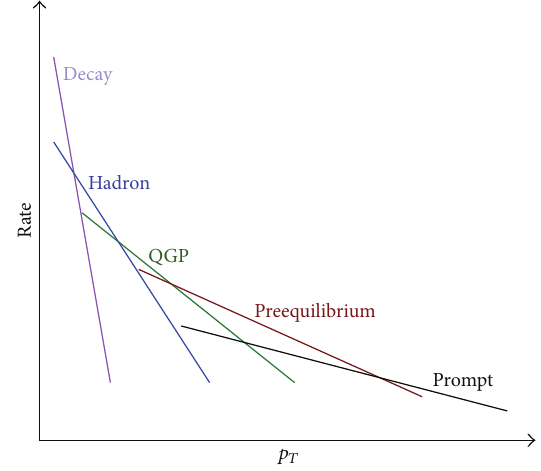
Figure 1: Schematic diagram of different sources of photon pro- duction in heavy ion collision as function of transverse momentum ( 𝑝 𝑇 ). Figure 2: Expected different sources of dilepton production in HIC as function of invariant mass